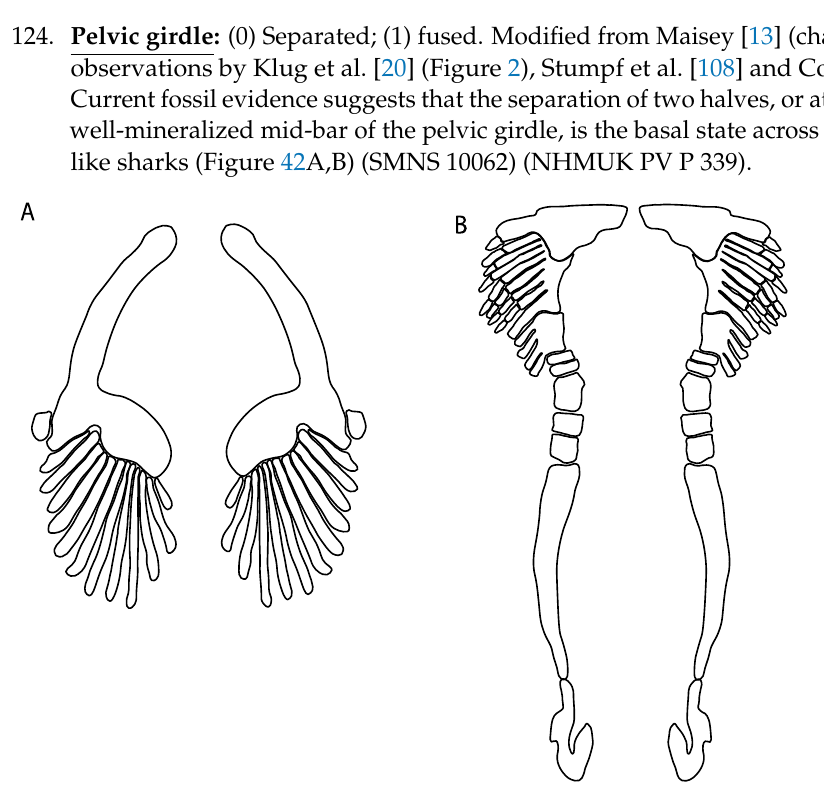
Figure 42. Dorsal view of pelvic girdle. State (0): ( A ) Chimaera cubana (USNM 400700, https://sharksrays.org/ (accessed on 25 March 2020)); ( B ) Reconstruction of Hybodus hauffianus (SMNS 10050).